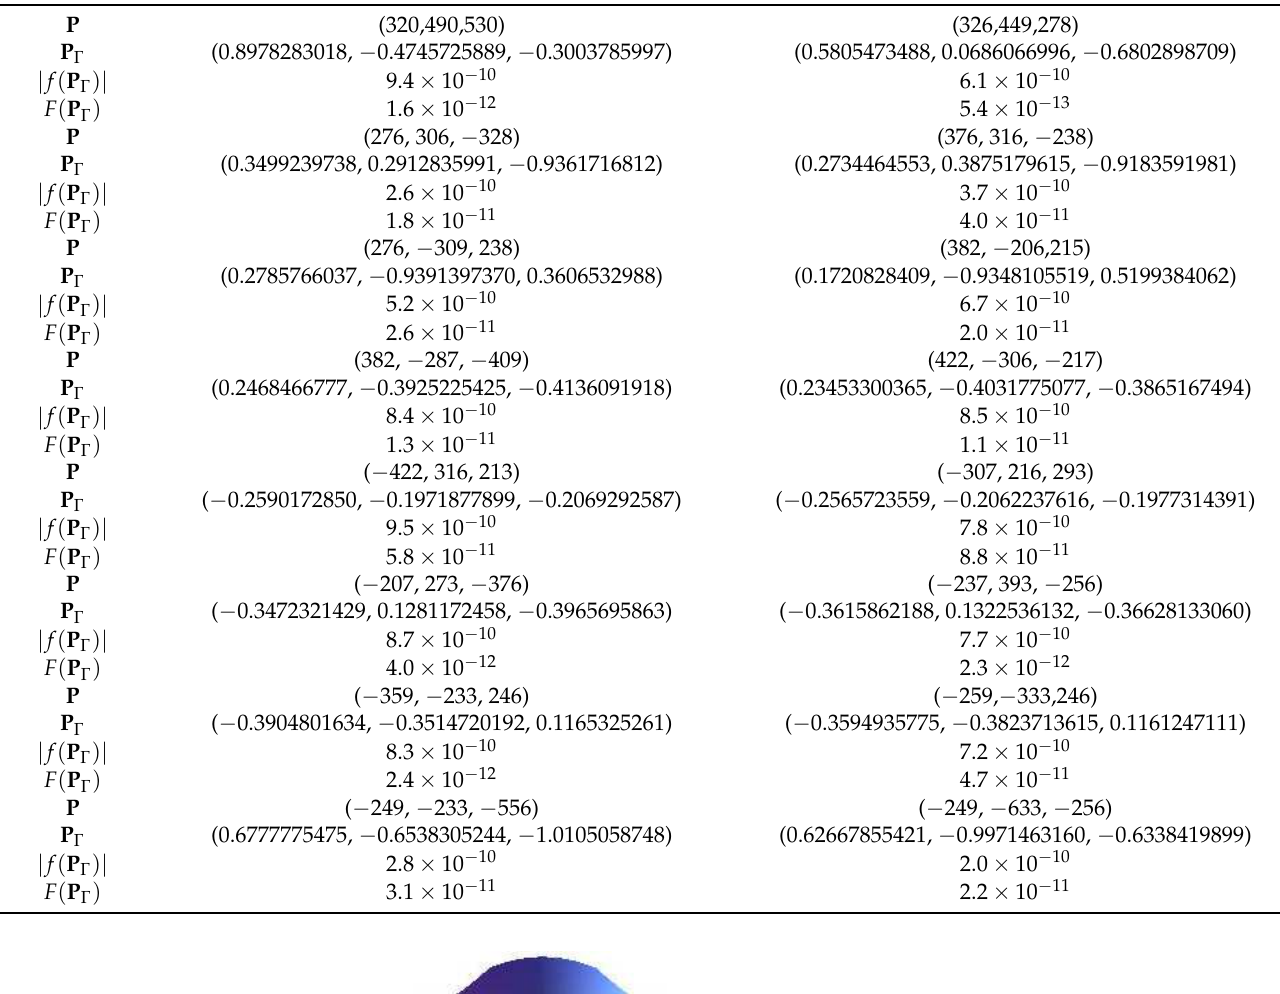
Table 2. The obtained running results of Algorithm 4 through Example 2.